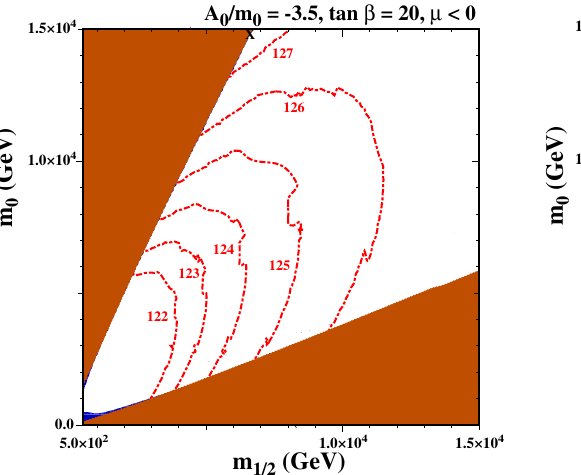
Fig. 5 The ( m 1 / 2 , m 0 ) planes in the CMSSM with tan β = 20. In the left panel, A 0 = − 3 . 5 m 0 and μ < 0, whereas in the right panel A 0 = 2 . 75 m 0 and μ > 0. Strips with the allowed cosmological LSP density are shaded dark blue (enhanced so that 0 . 01 < (cid:12) h 2 < 2 . 0